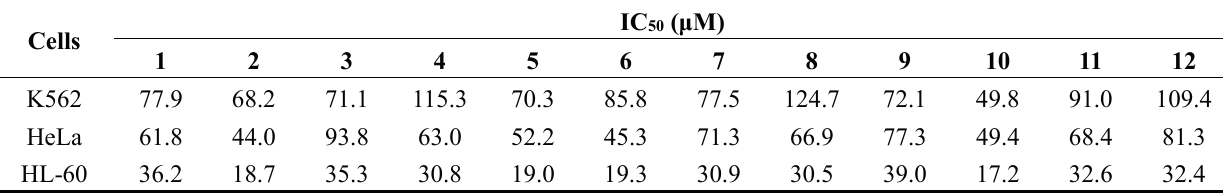
Table 2. Half inhibitory concentration (IC 50 ) of 1 – 12 on human cancer K562, HL-60 and HeLa cells. a Cells